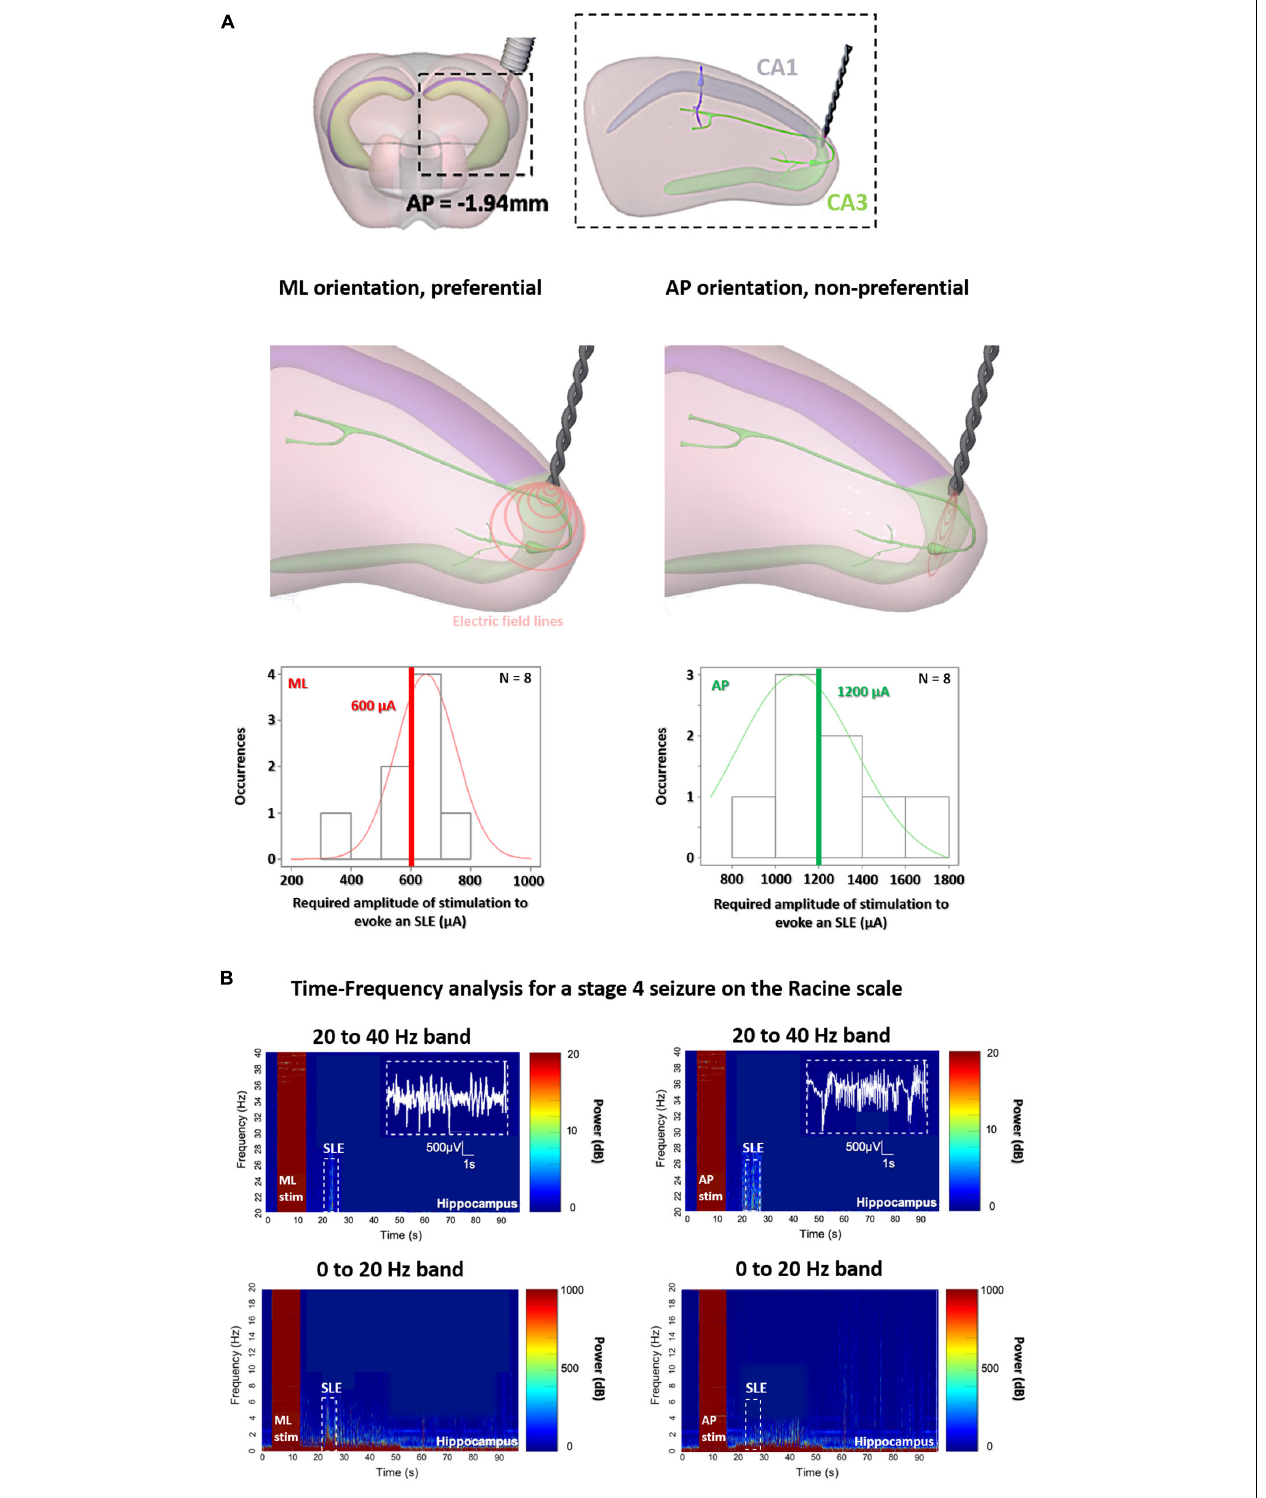
FIGURE 4 | Orientation-controlled stimulation of SLEs in the hippocampus with classic implanted stimulators. (A) Stimulation at the border of CA3 and CA1, for implantable electrodes with preferential medio-lateral (ML) orientations having equipotential surfaces of electric field parallel to axons, and with non-preferential anterior-posterior (AP) orientations having equipotential surfaces of electric field perpendicular to axons. (B) As soon as the stage 4 on the Racine scale is reached, an increase in power intensity is shown with a peak in beta/gamma range oscillations between 20–40 Hz, correlating with SLEs (15 s after the stimulation) for implantable orientations, however, for AP (right panels) double the current is required.